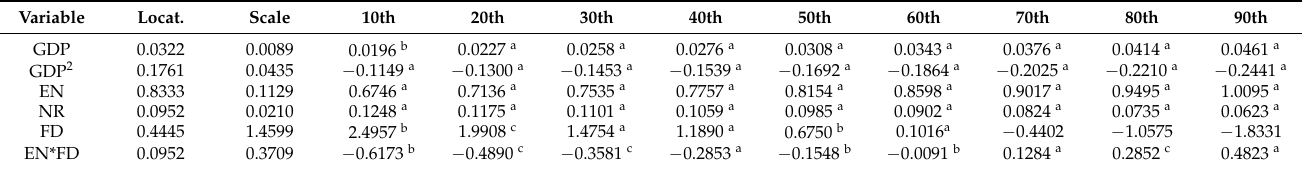
Table 6. MMQR estimation